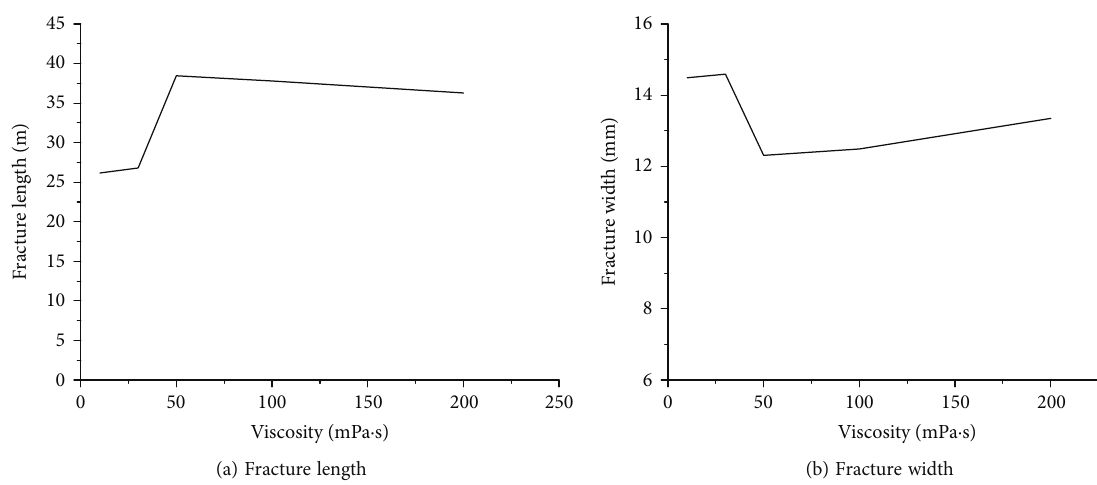
Figure 19: Fracture length and width at the NF approaching angle of 30 ° and fl uid viscosity of 10-200 mPa · s.